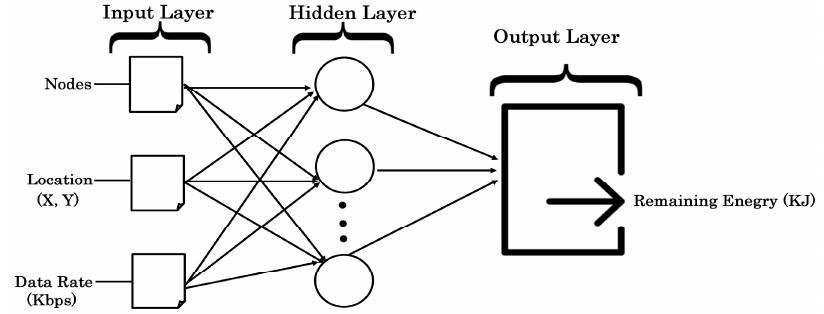
Figure 5. Artificial neural network (ANN) architecture.